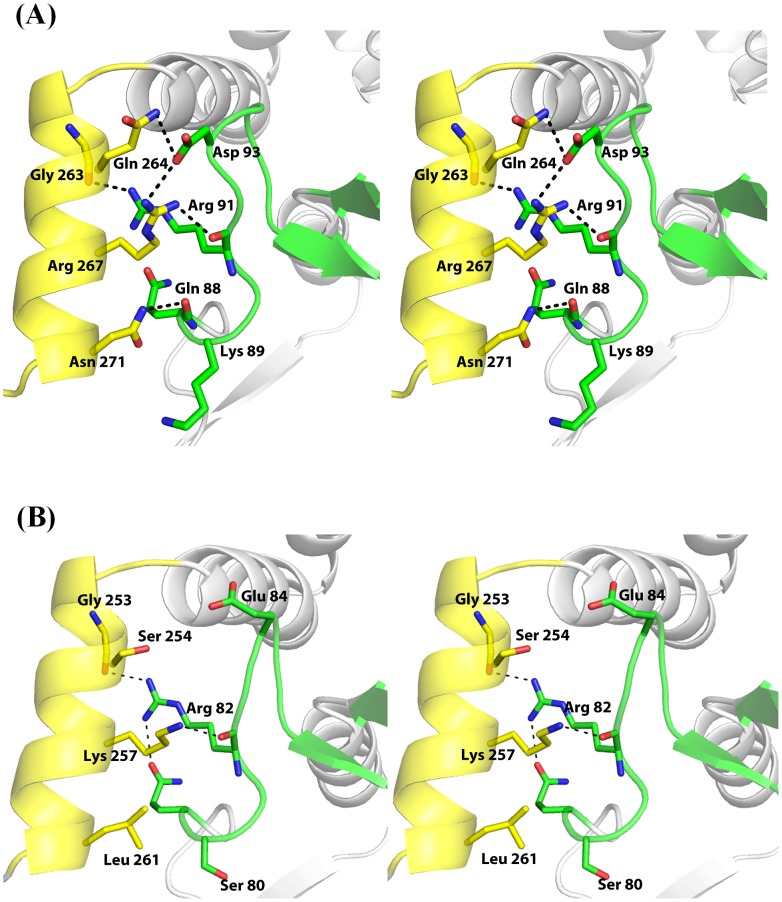
The interactions between the ordered A-loop and the reoriented C-helix in ecMenB:HNA-CoA (A) and scMenB:HNA-CoA (B).Residues located in the loop-helix interface are displayed in sticks with carbon atoms colored yellow for the A-loop and green for the C-helix. Dashed lines represent distances less than 3.5 Å.